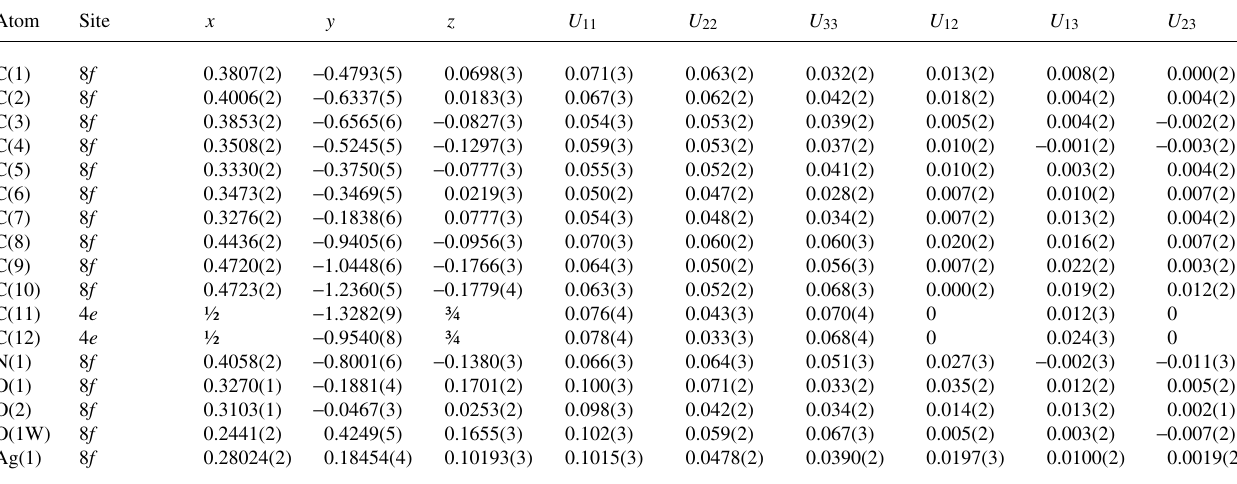
Table 3. Atomic coordinates and displacement parameters (in Å 2 )